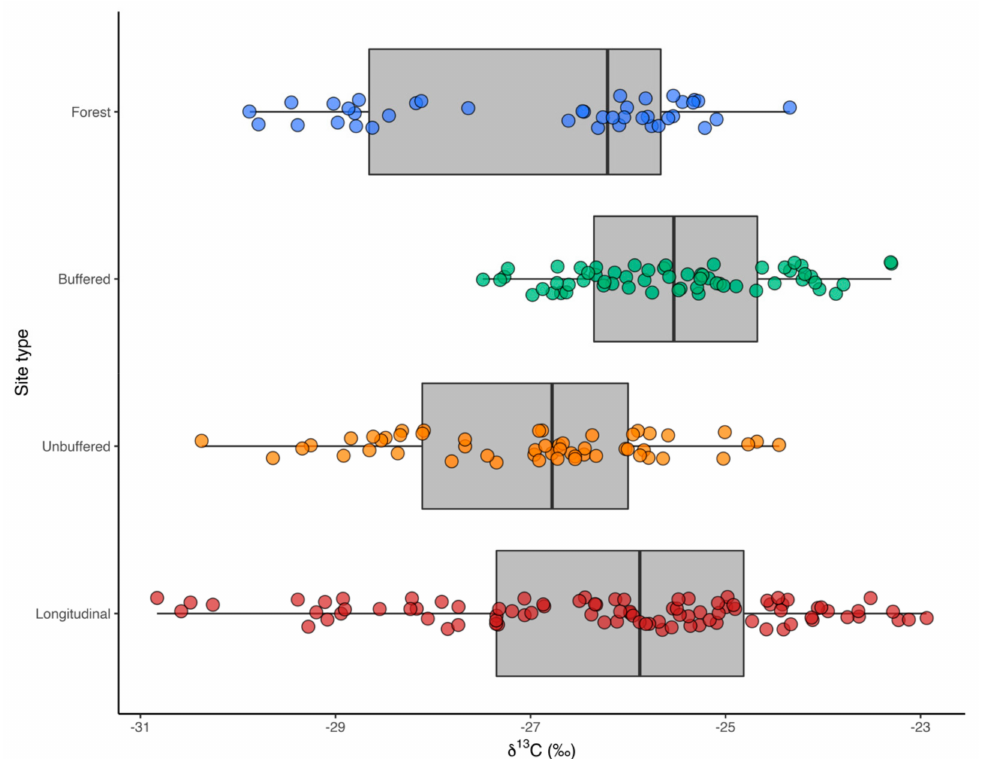
Figure 5. Distribution of δ 13 C signals across the four site types in Oslo, Norway: forested reference sites (n = 4; isotope samples: 40), unbuffered (n = 6; isotope samples: 53), buffered (n = 6; isotope samples: 60) and longitudinal (n=8; isotope samples: 91) sites across Oslo. In each box plot, the center line indicates the median, the box limits indicate the upper and lower quartiles, the whiskers indicate the 1.5 × interquartile